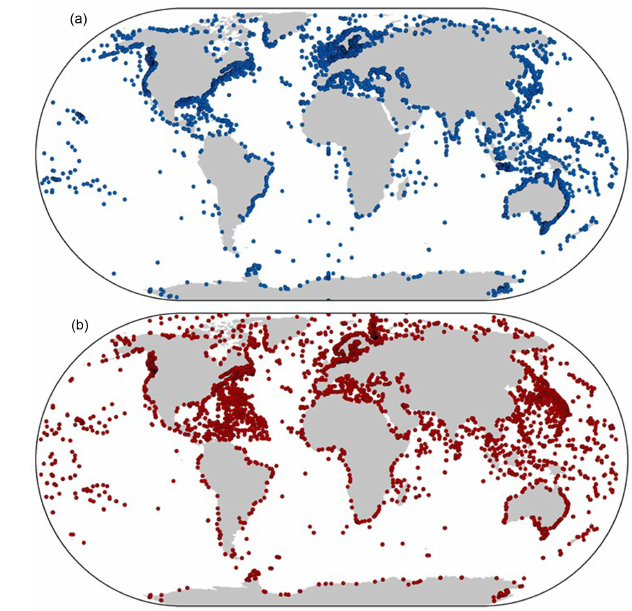
Figure 1. Map location of the stations identified with location is- sues. Map (a) shows daily stations (blue dots) and map (b) shows monthly stations (red